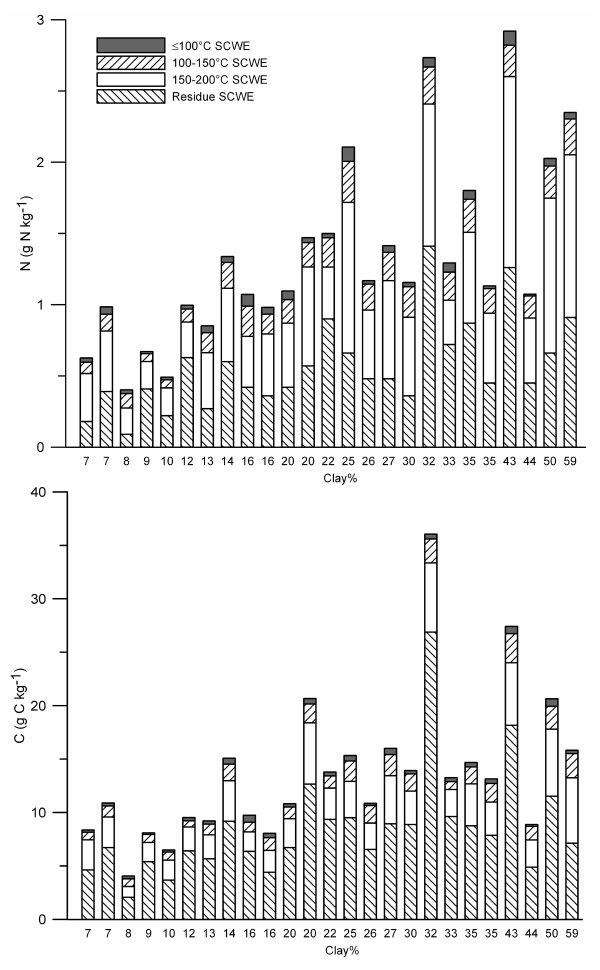
Fig. 2. Distribution of soil N and OC over subcritical water frac- tions. Fractions were subsequently extracted at 100 ( ≤ 100 ◦ C SCWE N or OC), 150 (100–150 ◦ C SCWE N or OC), 200 ◦ C (150– 200 ◦ C SCWE N or OC), leaving an extraction residue (Residue SCWE N or OC).